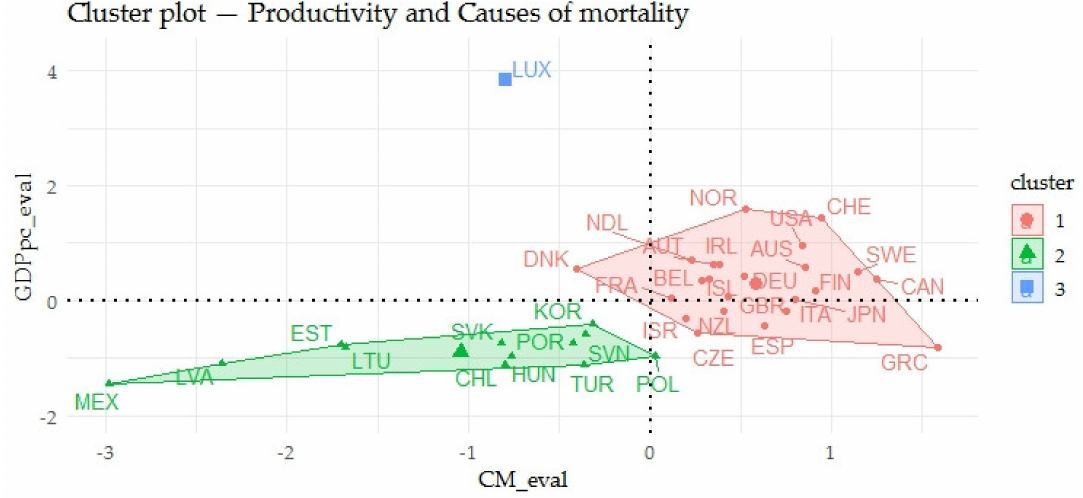
Figure 4. Clusters of OECD—the relations of economic prosperity and gender inequalities in causes of